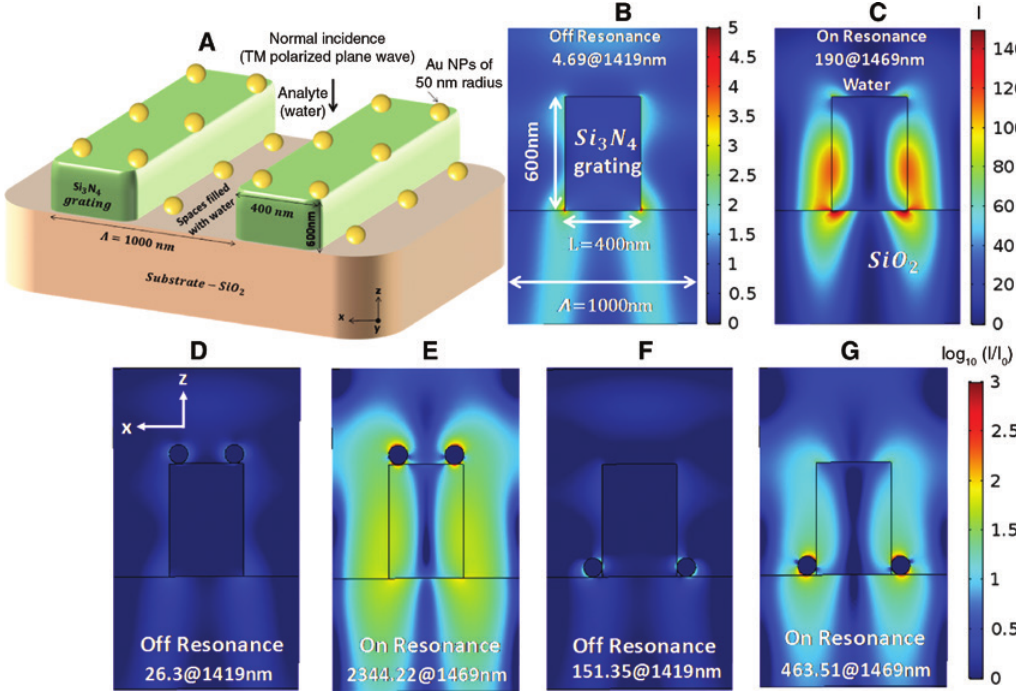
Figure 25: Ultrahigh field enhancement under GMR-LSP coupling. (A) Guided resonant grating structure with AuNPs on top. (B–C) Field distribution calculations without the AuNPs at and off resonance. (D–G) Field distribution calculations with the AuNPs on the top or bottom corners at and off